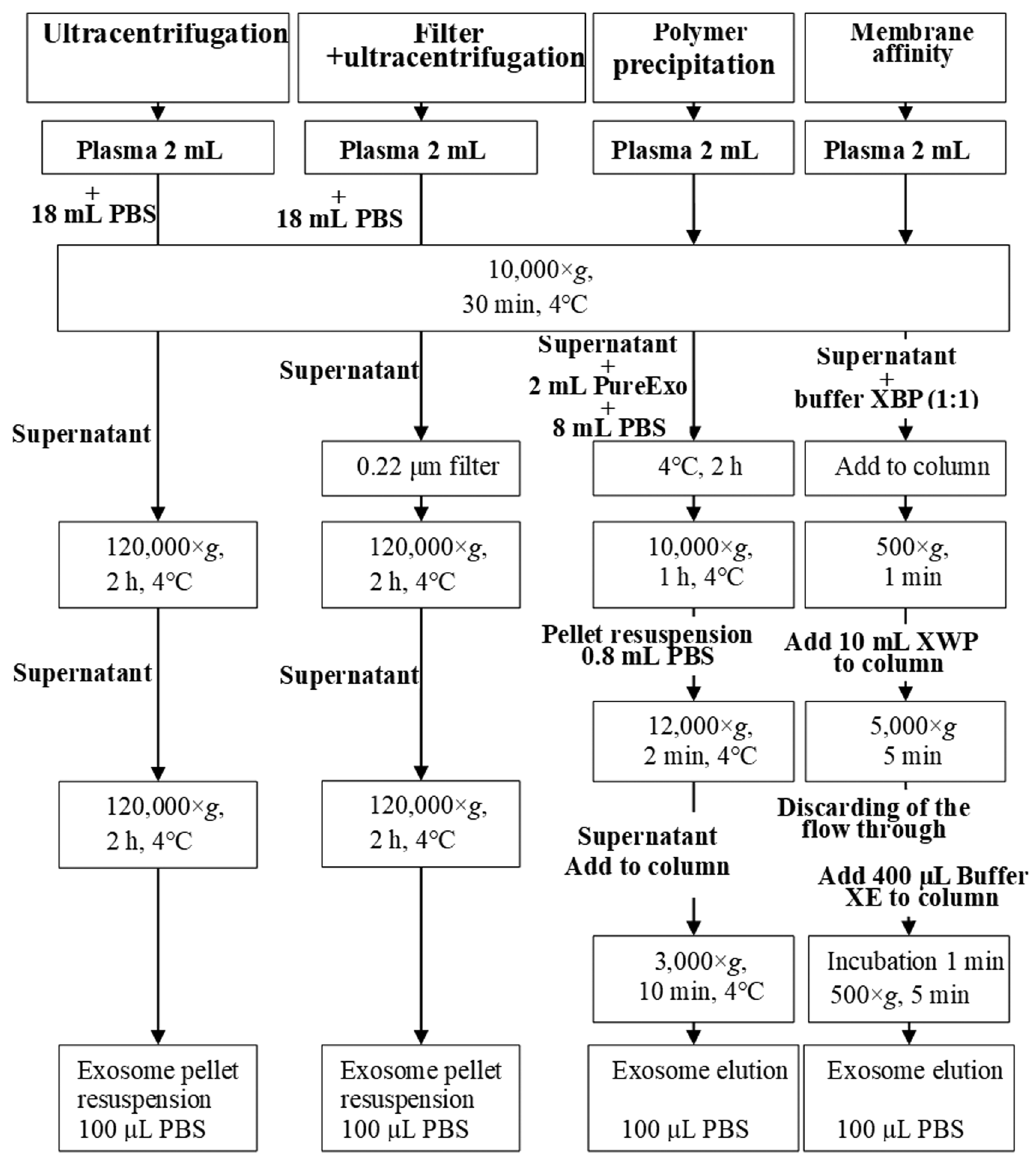
Figure 1: Exosome isolation fl ow